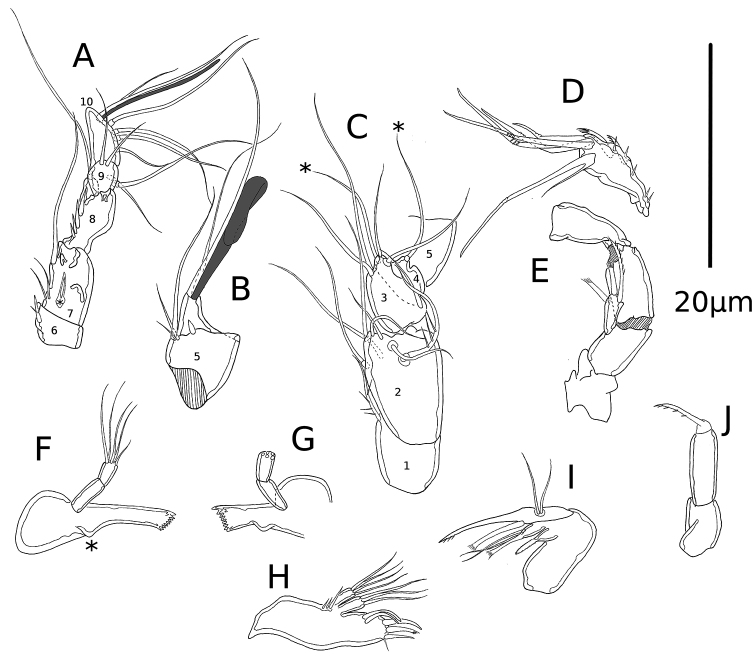
Psammonitocrella
kumeyaayi sp. nov., male. A 6th to 10thA1 segments B 5thA1 segment C 1st to 5thA1 segments Denp2 of A2EA2 with unarmed enp2FmdGmd with unarmed palp Hmx1Imx2Jmxp. Asterisk mark the setae of the 4thA1 segment, and the md oral bulge.